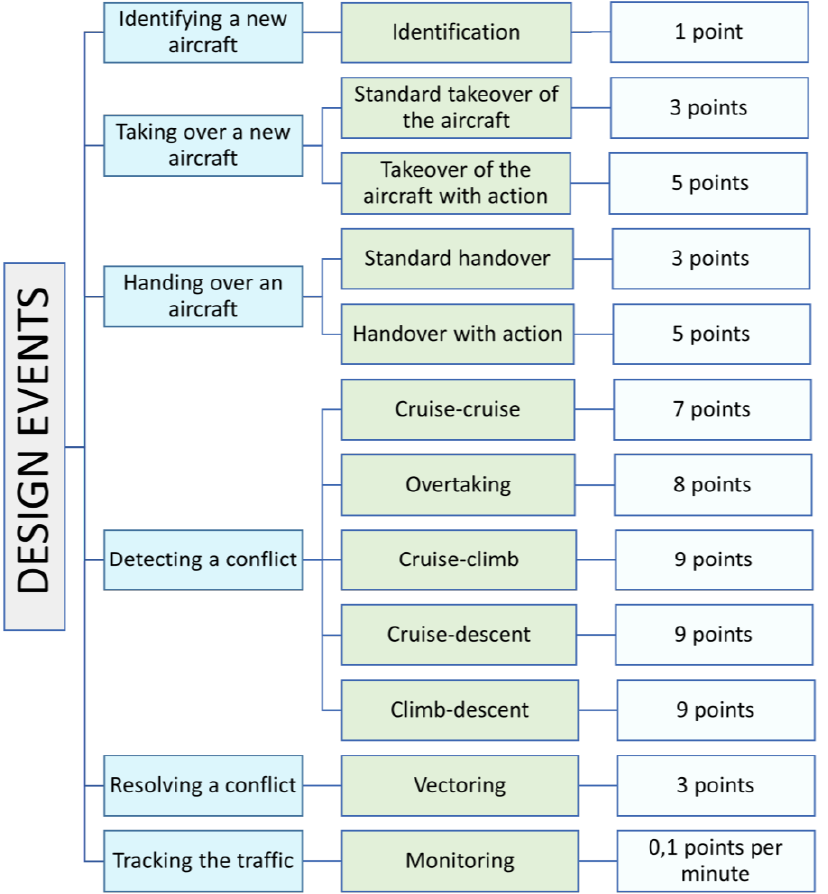
Figure 2. Identification of the key activities carried out by ATCOs (blue rectangles) and the ATC events associated with them (green rectangles). In total, twelve ATC events form the basis of the simulations in the experiment conducted.